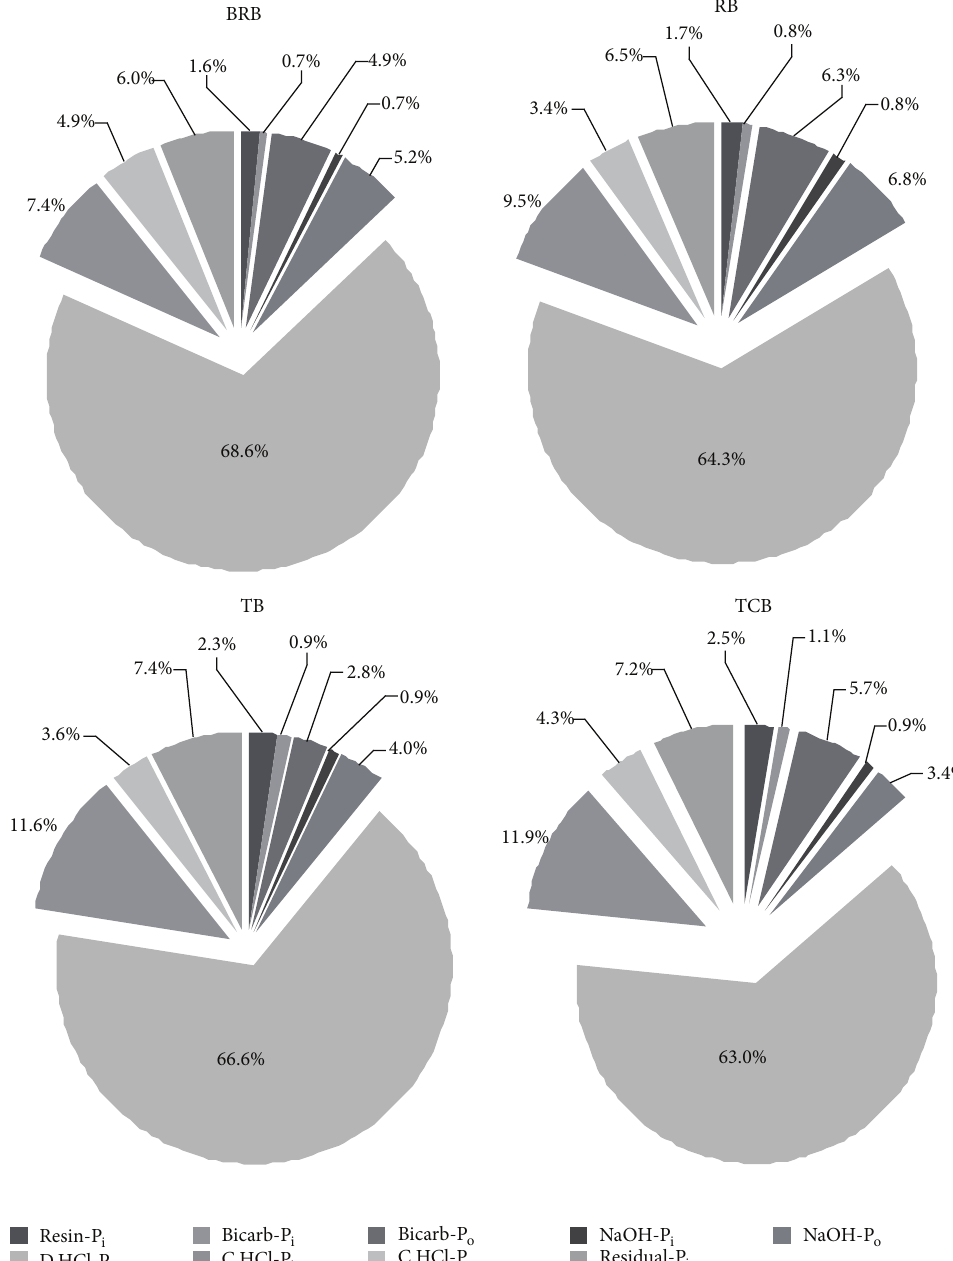
Figure 2: Soil P fractions in BRB, RB, TB, and TCB soils (P fractions including Resin-P, Bicarb-P i , NaOH-P i , D.HCl-P i , C.HCl-P i , Bicarb-P o , NaOH-P o , C.HCl-P o , and